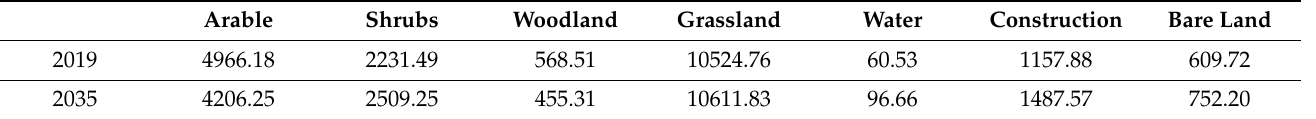
Table 1. Simulation scale result table (km 2 ) + specific